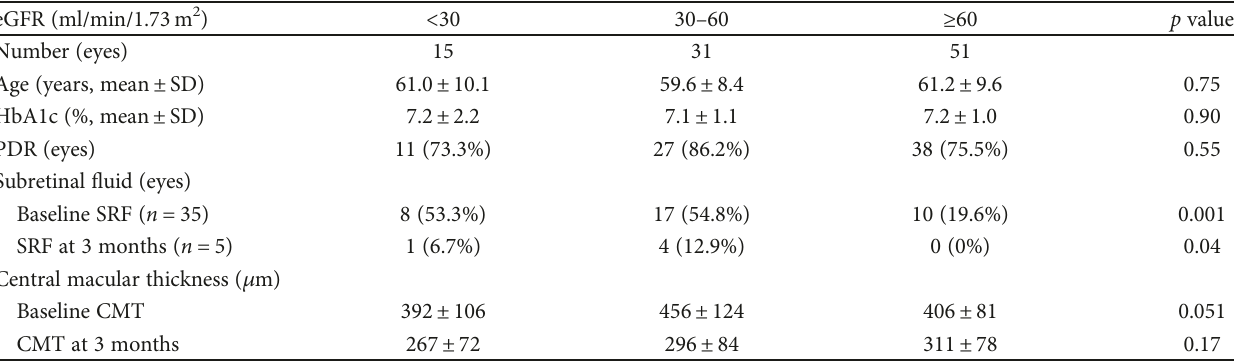
Table 2: Clinical parameters according to di ff erent kidney